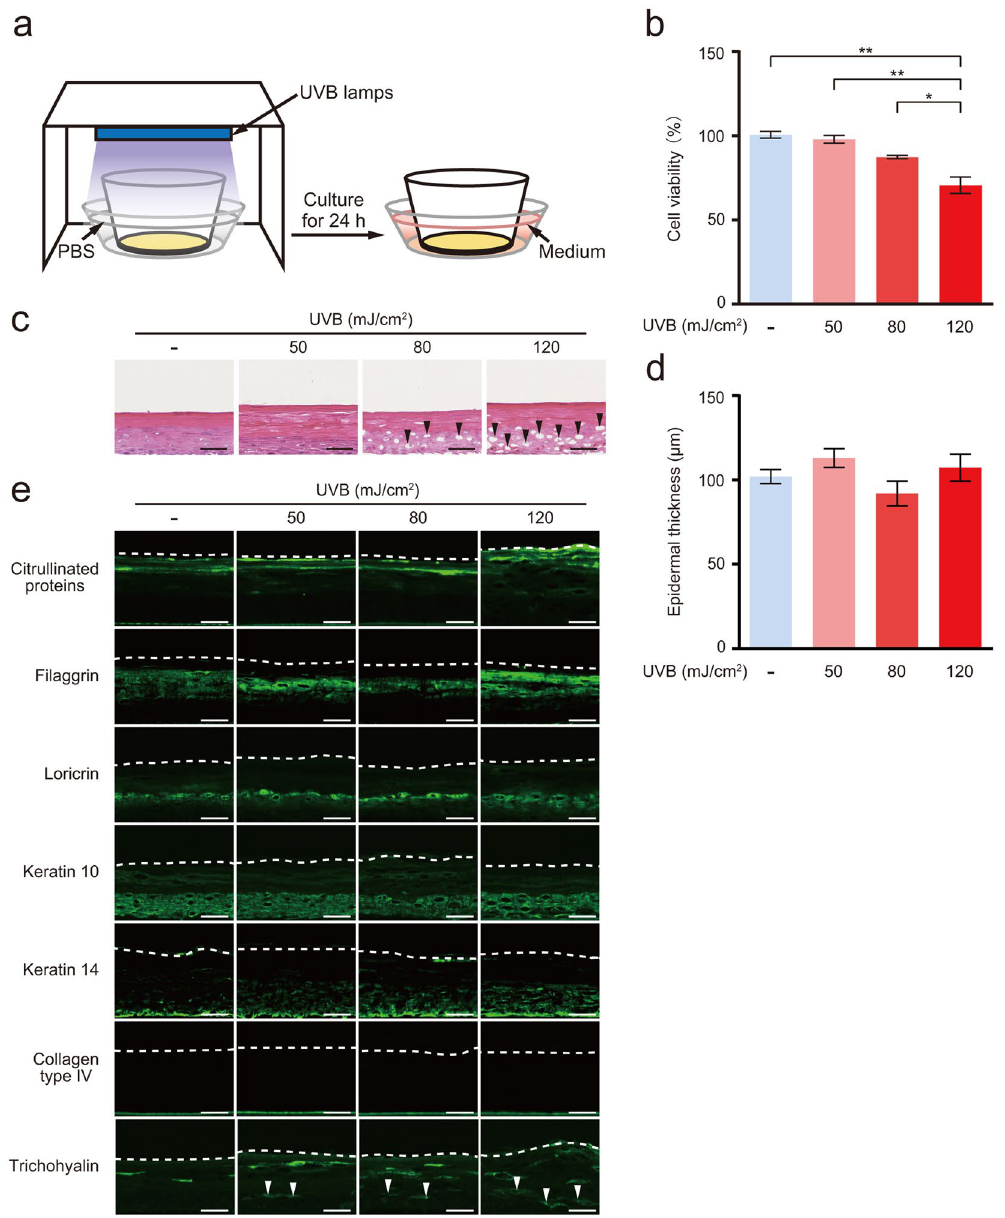
Figure 2. UVB induced cell damage in the reconstituted human epidermis. ( a ) The reconstituted human epidermis was irradiated with 50, 80 or 120 mJ/ mJ/cm 22 UVB. For irradiation, the medium was replaced with PBS beneath the culture insert, and the culture plate was irradiated without the plastic plate lid. After irradiation, PBS was replaced with fresh medium, and the epidermis was cultured for 24 h. ( b ) The viability of cells in the UVB-irradiated epidermis was measured using the MTT assay. Values are presented as the means ± SEM of three wells. ( c ) Histological changes in the UVB-irradiated epidermis. Black arrowheads indicate gaps formed by holes. Bars = 50 µ m. ( d ) Thickness of the UVB-irradiated epidermis. Epidermal thickness was measured as the distance between the top of the membrane and the bottom of the cornified layer in three randomly selected fields from each epidermis. Values are presented as the means ± SEM of three wells. ( e ) Immunofluorescence staining for citrullinated proteins, filaggrin, loricrin, keratin 10, keratin 14, collagen type IV, and trichohyalin in the UVB-irradiated epidermis. The dotted line represents the bottom of the cornified layer. White arrowheads indicate trichohyalin. Bar = 50 µ m. The statistical analysis was performed using one-way ANOVA followed by Tukey’s post hoc test. * P < 0.05, ** P <